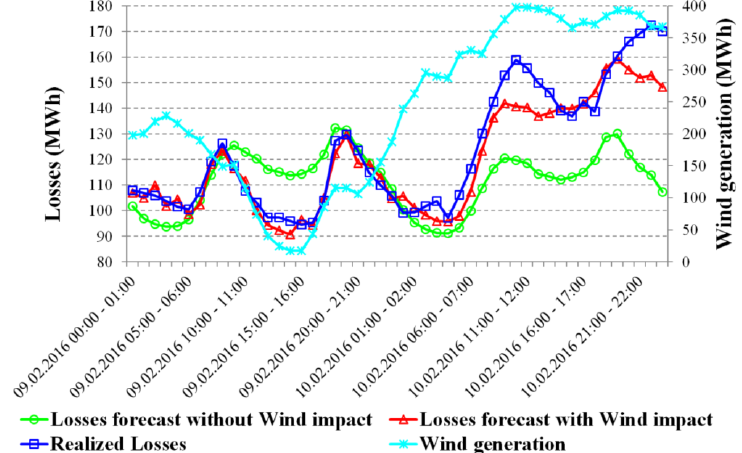
Figure 4. Transmission losses forecasting with and without wind generation in one month, repro- duced with permission from